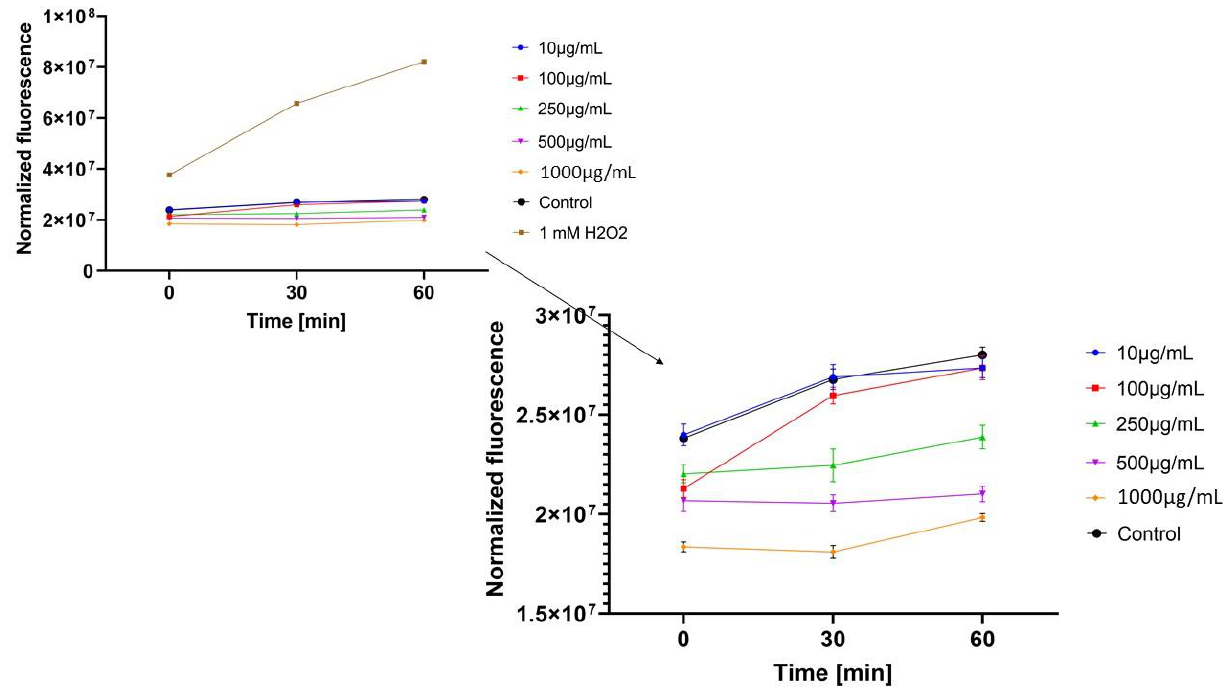
Figure 6. The effect of Epilobium angustifolium L. extract on the 2’,7’-dichlorofluorescein (DCF) fluorescence in keratinocyte cells (HaCaT). The data are expressed as the mean ± SD of 3 independent experiments, each of which consisted of 3 replicates per treatment group.